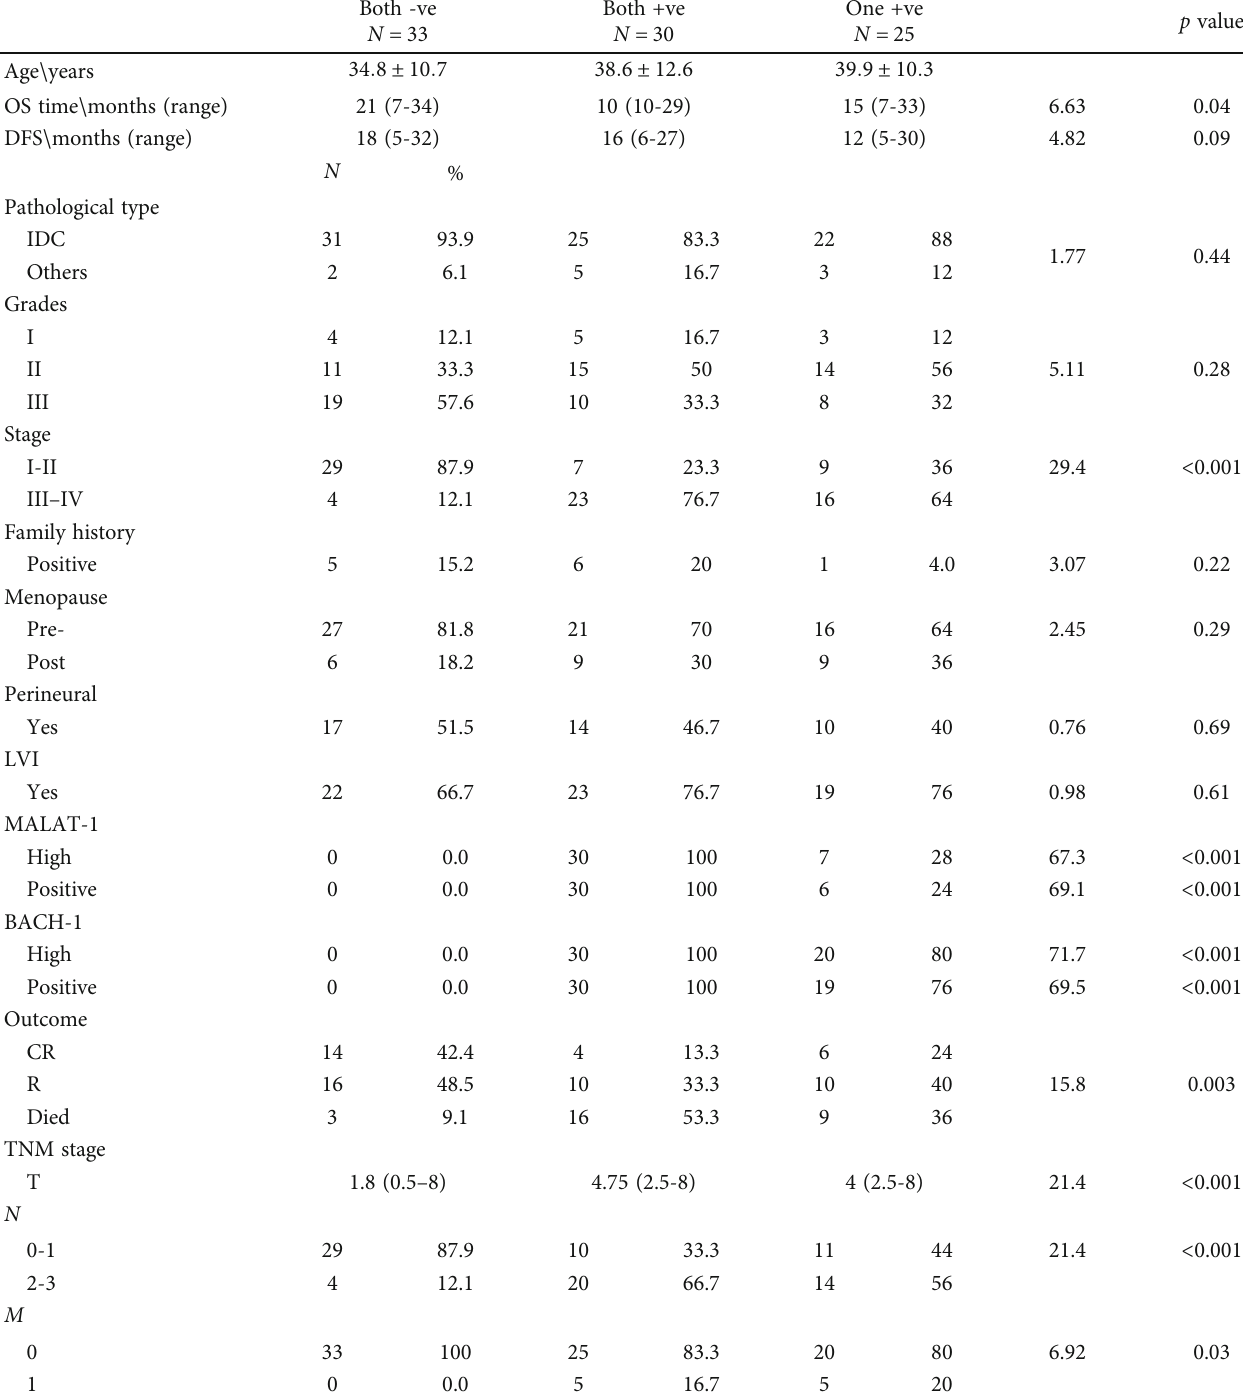
Table 3: Relation between MALAT1 and BACH1 expression and basic characteristics of studied TNBC. Both -ve N =